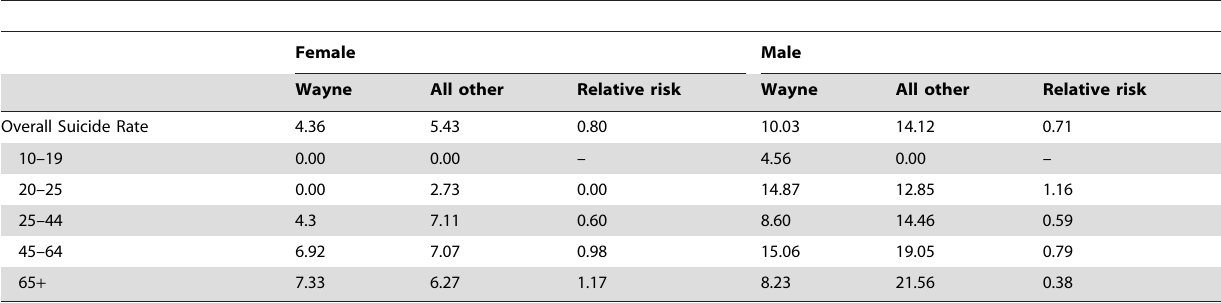
Table 3. Age-adjusted suicide rates (per 100,000 per year) inside and outside of Wayne county as well as relative risk of suicide in Wayne county relative to all other counties among Arab ethnicity males and females aged 10 and older in Michigan, 1990–2007.